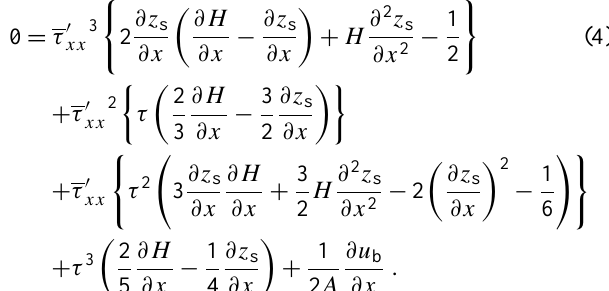
Fig. 1. Landsat 7 image of Columbia Glacier acquired 23 August 2010 overlaid with the curvilinear coordinate system ( ζ in km) employed by Meier et al. (1985) to describe the “main” flowline (M) and tributaries “west” (W), “main-west” (MW) and “east” (E). Annual terminus position over the 1984 to 2010 period is also shown (updated from Krimmel, 2001). Inset: Location of Columbia Glacier in